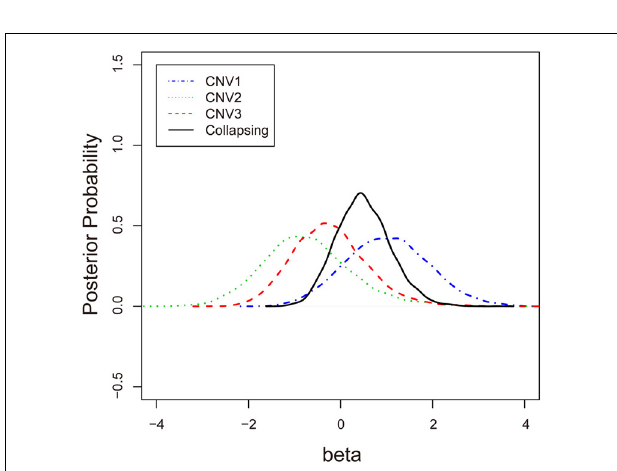
family contains the de novo mutation, it cannot estimate the